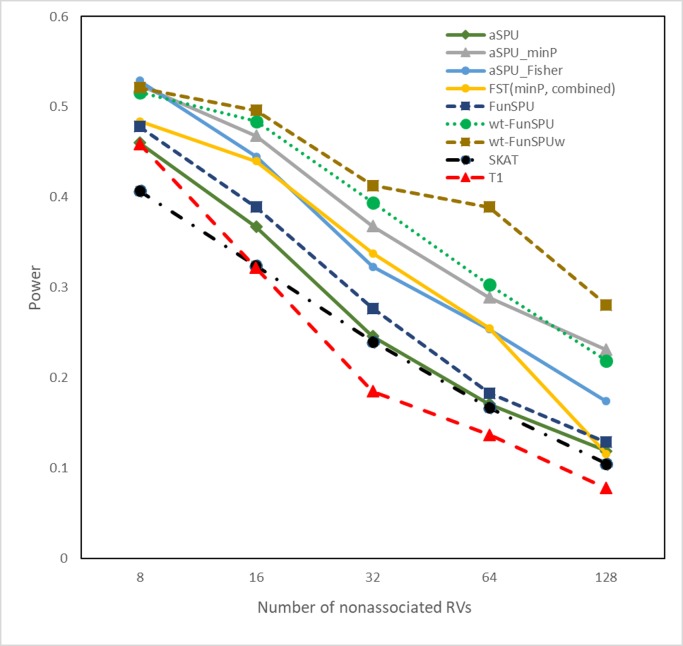
Empirical power of various tests for eight causal RVs and increasing number of nonassociated RVs at significance level α = 0.05.The incorporated annotations for association tests include one out of three informative annotations and three noninformative annotations (Scenario B). All the results were based on 1000 simulation replications.